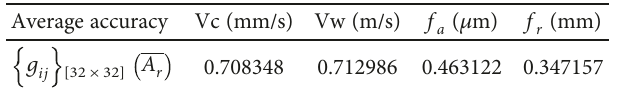
Table 3: Average accuracies of predicted results with random